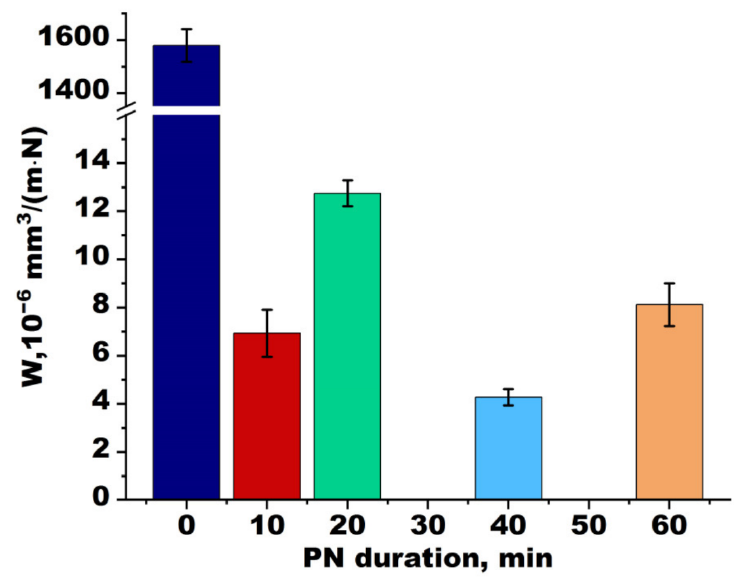
Figure 10. The dependence of specific wear coefficients of the samples based on the PN duration.